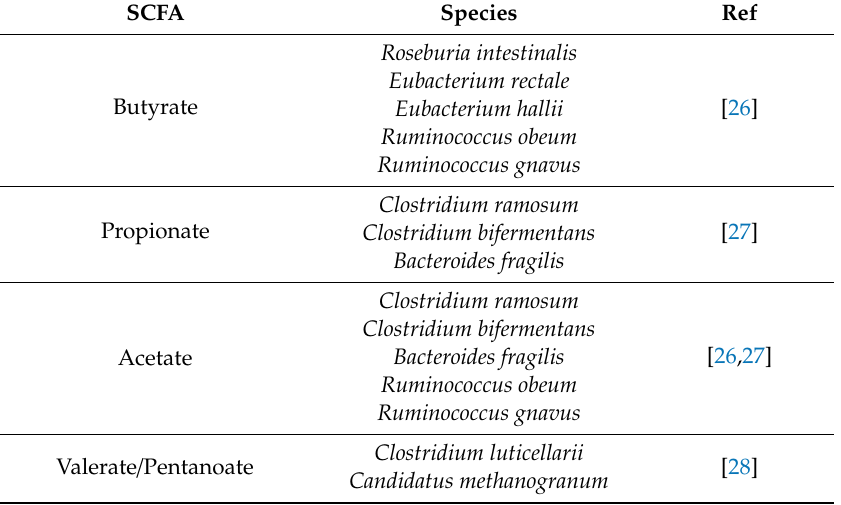
Table 1. Main SCFAs, preferentially produced by some members of gut residing bacterial